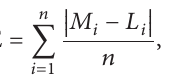
in the short-wave infrared reflectivity is lower than the near infrared wave band, thus spectral relation between short-wave infrared and near infrared band can distinguish the difference between water and land mixed pixels [35]. Figure 3 presents the steps of the water detection